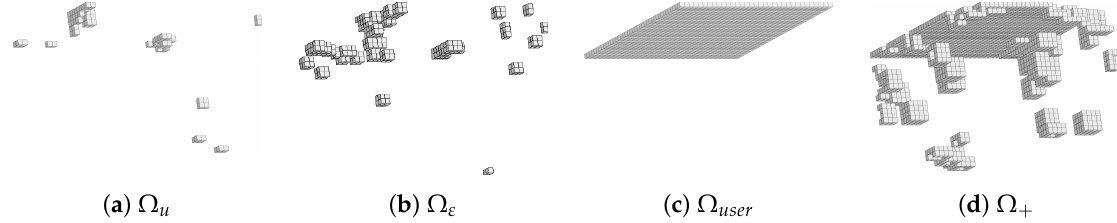
Figure 7. Different subdomains for the selected RED for k = 25.